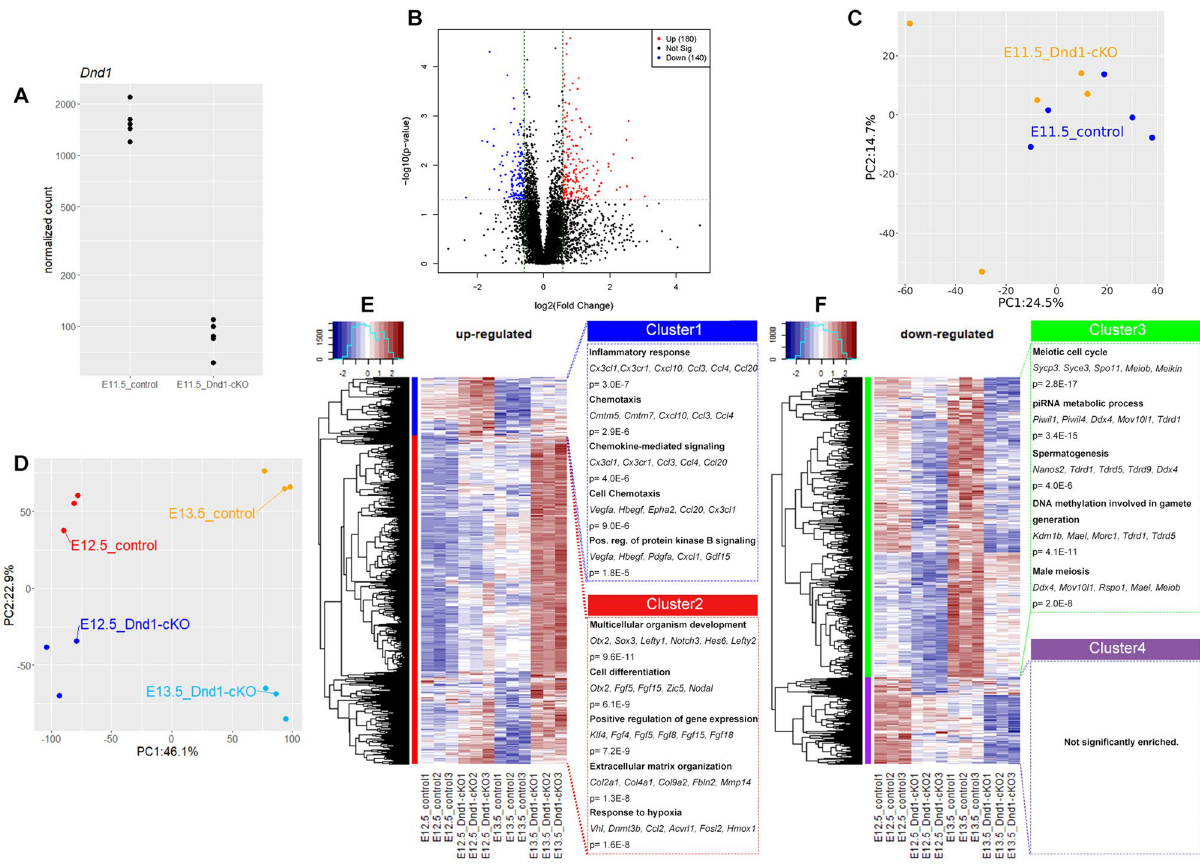
Figure 6. Transcriptomic analysis of PGCs in testes from the control and Dnd1 -cKO embryos. ( A ), Expression levels of Dnd1 transcript in each PGC from five independent control and Dnd1 -cKO embryos are indicated by read counts in the sequence analyses. ( B ), Volcano plot of RNA-seq data of PGCs from the control and Dnd1 -cKO embryos at E11.5. Red: p < 0.05, fold change > 1.5; blue: p < 0.05, fold change < 1.5. ( C ) PCA of the transcriptomes of PGCs from control and Dnd1 -cKO mice at E11.5. Each dot represents a single transcriptome. Transcriptomes from five biological replicates are plotted. ( D ), PCA of the transcriptomes of PGCs in testes from control ( Dnd1 flox/flox ; Nanog-GFP ) and Dnd1 -cKO ( Dnd1 flox/flox ; Nanog-GFP; Rosa26-CreER T2 ) embryos at E12.5 and E13.5. Each dot represents a single transcriptome. Transcriptomes from three replicates were plotted. ( E , F ), Heatmap representation of the expression and GO enrichment of genes upregulated ( E ) and downregulated ( F ) in PGCs from Dnd1 -cKO embryos compared to those from control embryos at E12.5 and E13.5. The heatmap was generated using the ‘heatmap.2’ function in the gplot package (ver.3.1.3, https://